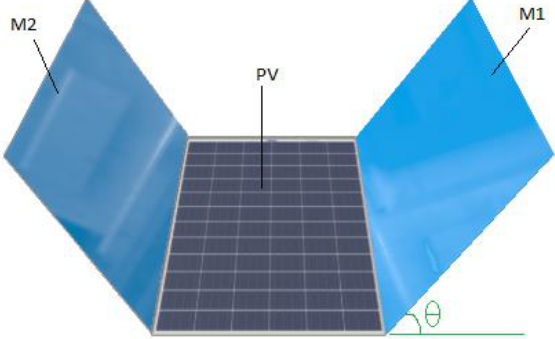
Figure 1. Schematic diagram of the V-trough. Here, M1 and M2 are the first and second mirrors, and θ is the inclination angle [8].